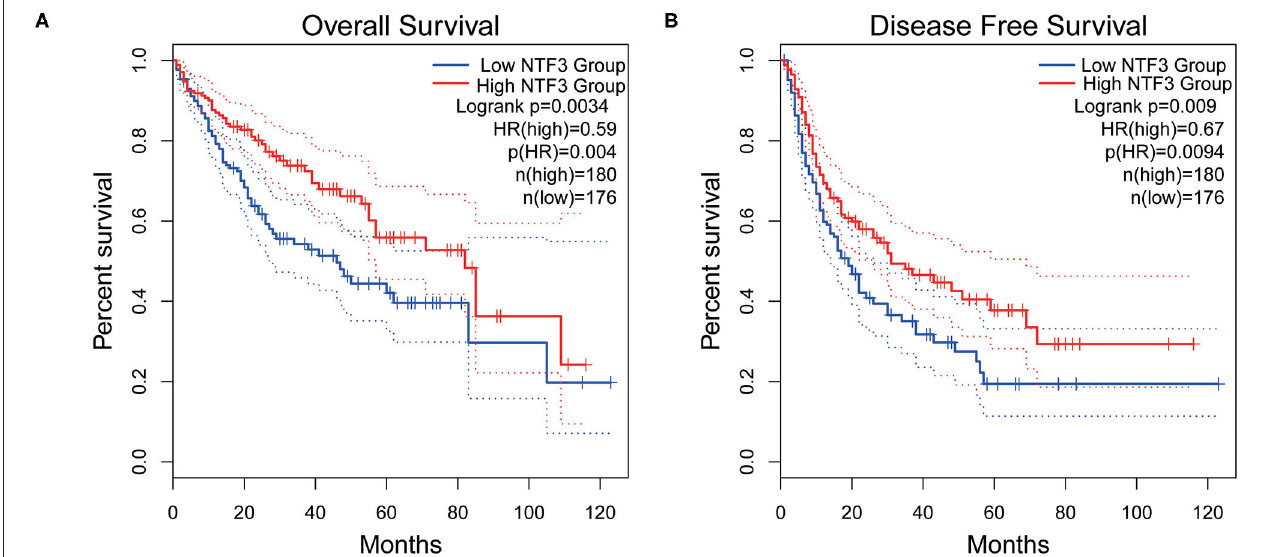
FIGURE 4 | The prognostic value of NTF3 in HCC is analyzed by GEPIA. (A) OS, overall survival. (B) DFS, disease free survival.